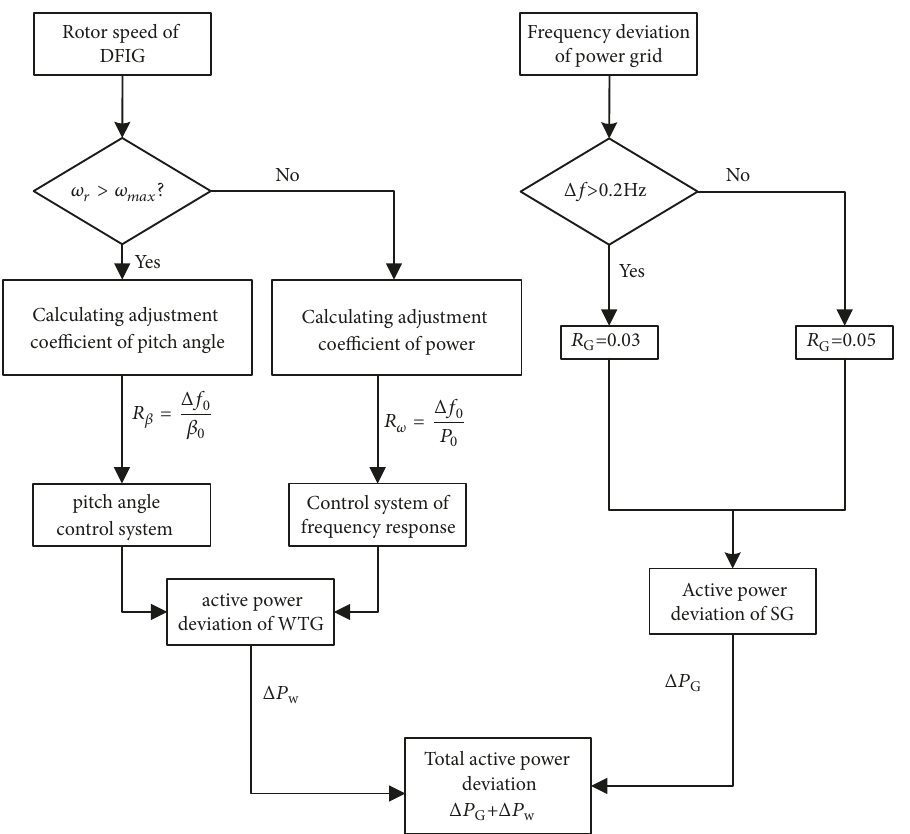
Figure 4: Flow chart of the proposed